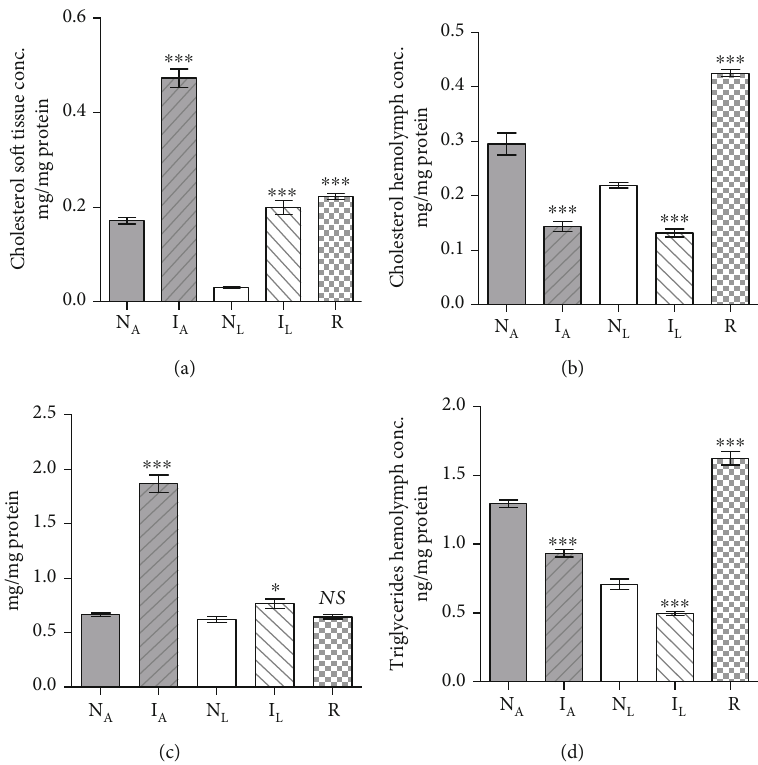
Figure 4: Each column represents mean soft tissue cholesterol (a), hemolymph cholesterol (b), soft tissue triglycerides (c), and hemolymph triglyceride (d) content for fi ve B. truncatus snails, and vertical bars the SE about the mean. N naïve-lettuce fed; I : infected-lettuce fed; R: resistant snails. Statistical di ff erences between naïve and infected or resistant same diet-fed L snails are shown; ∗∗∗ P < 0 : 001 , ∗ P < 0 : 05 . NS: not signi fi